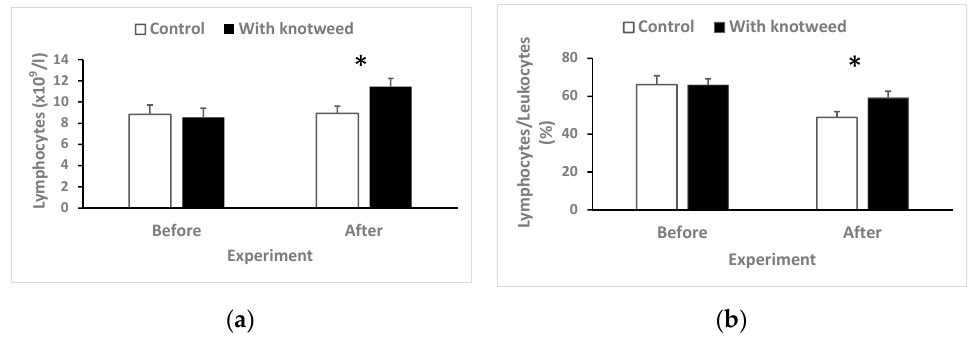
Figure 13. The total number of lymphocytes ( a ) and the ratio of lymphocytes to leukocytes ( b ) in all